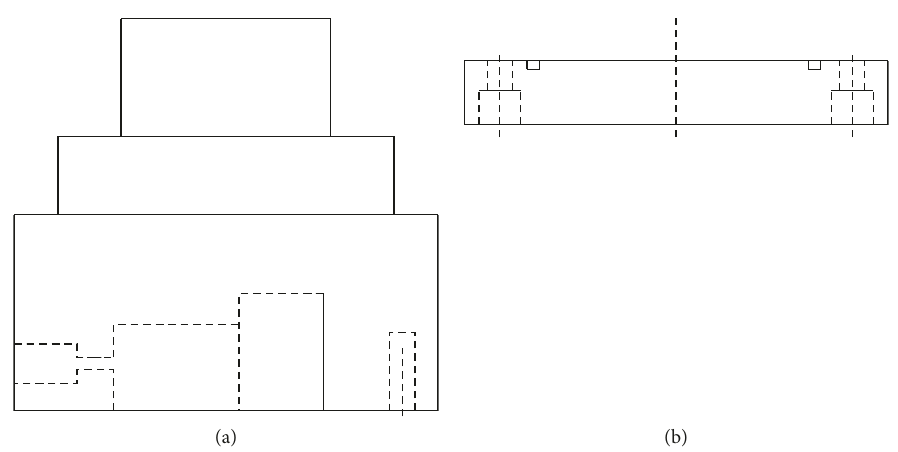
Figure 13: Test head side view: (a) main part and (b) closed